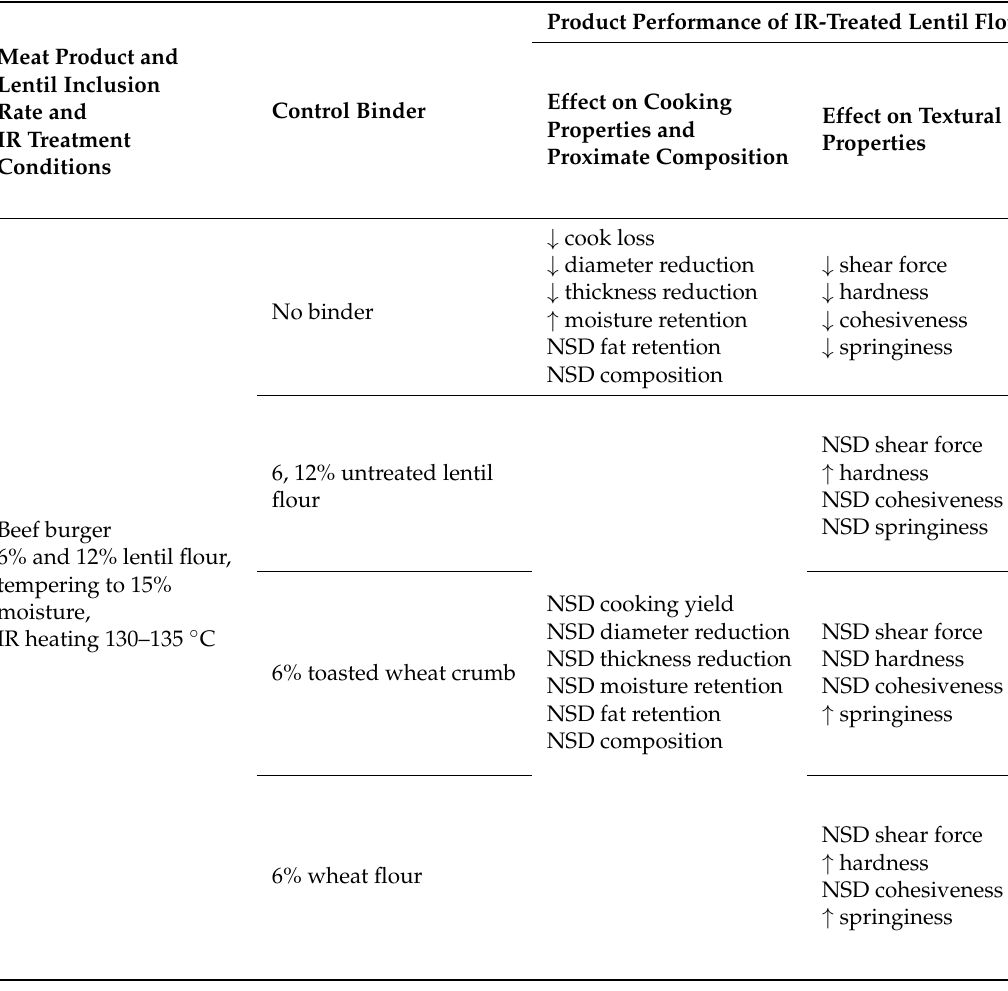
Table 6. Performance of IR-treated lentil flour in processed meat